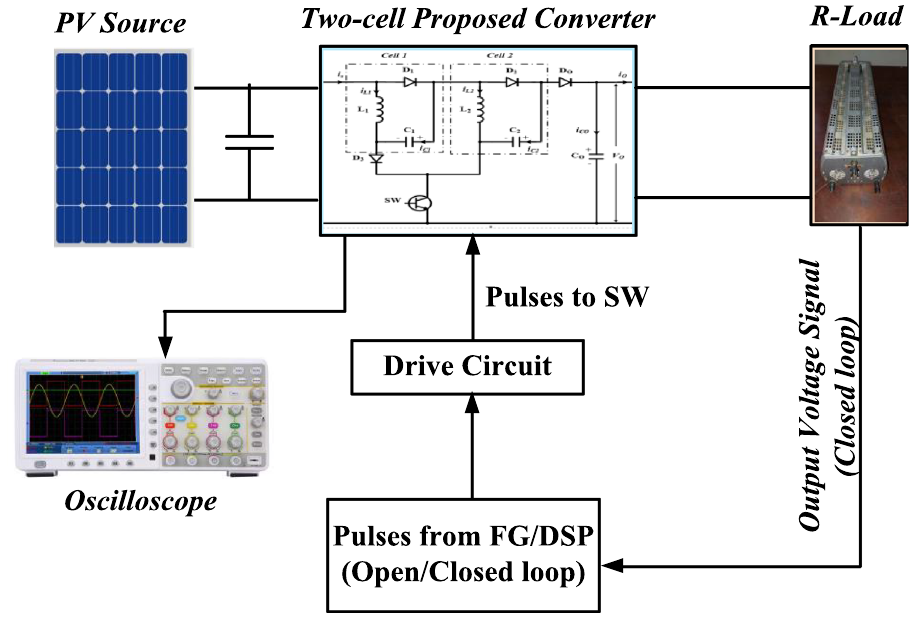
Figure 9. The schematic drawing for the test